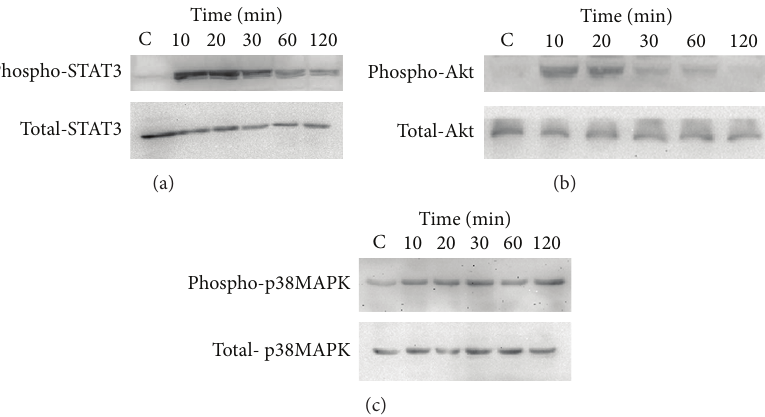
Figure 6: Effects of IL-27 on the activation of STAT3, p38MAPK, and PI3K-Akt signaling pathways in HTR-8/SVneo. (a) Representative Western blot analysis for the phosphorylation of STAT3. (b) Representative Western blot analysis for the phosphorylation of Akt. (c) Representative Western blot analysis for the phosphorylation of